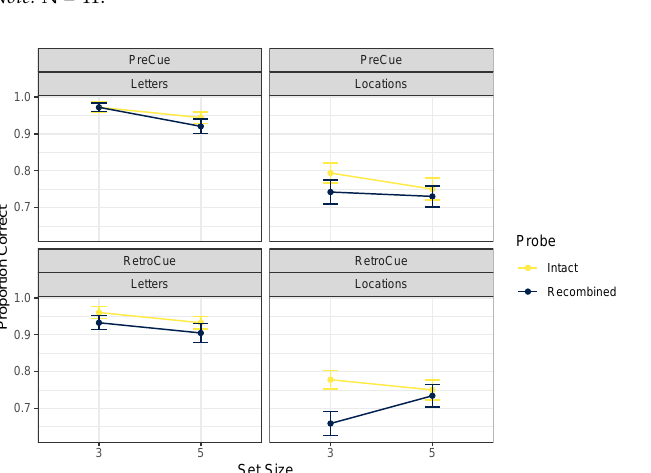
Figure 2. Mean proportions correct, Experiment 1. Error bars mark within-participant standard errors around the mean calculated with the Cousineau–Morey method